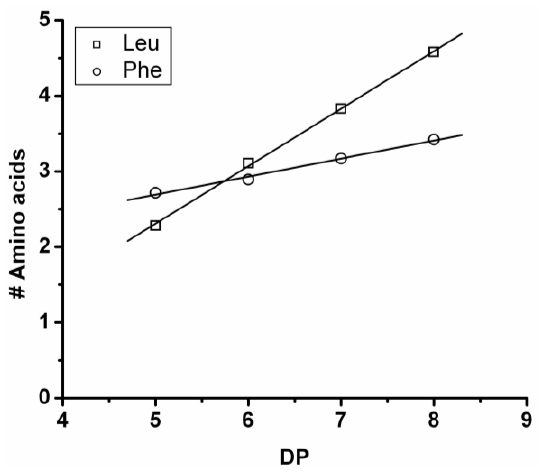
Figure 11. Average amount of amino acids in poly(Leu-co-Phe) for every observed